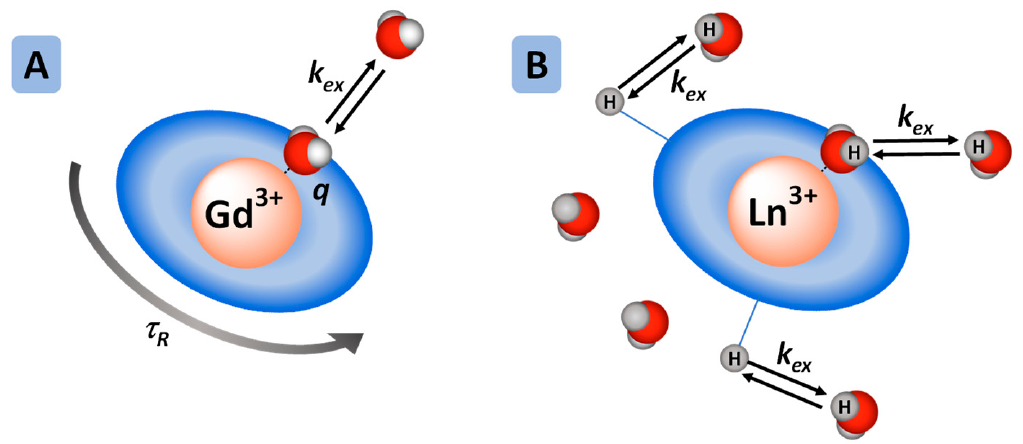
Figure 1. ( A ) Principal microscopic parameters that influence the relaxivity of Gd 3 + -based contrast agents. ( B ) ParaCEST Ln 3+ complex: the ParaCEST effect originates from proton exchange between the bulk water and protons on the ligand or on the coordinated water molecules.